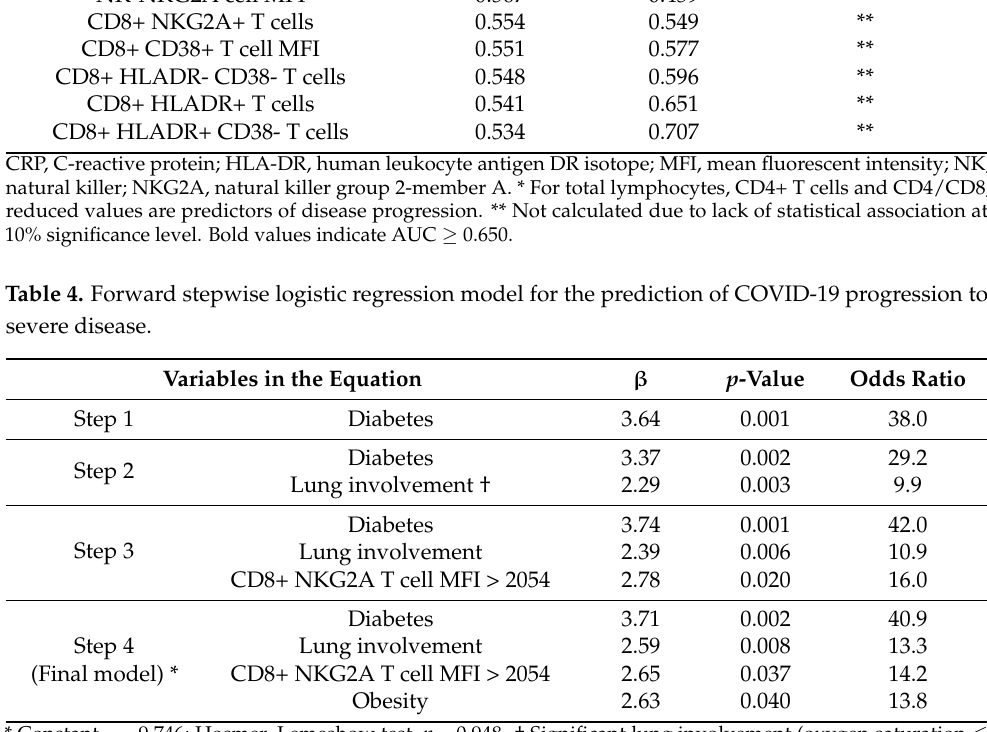
Area under Curve